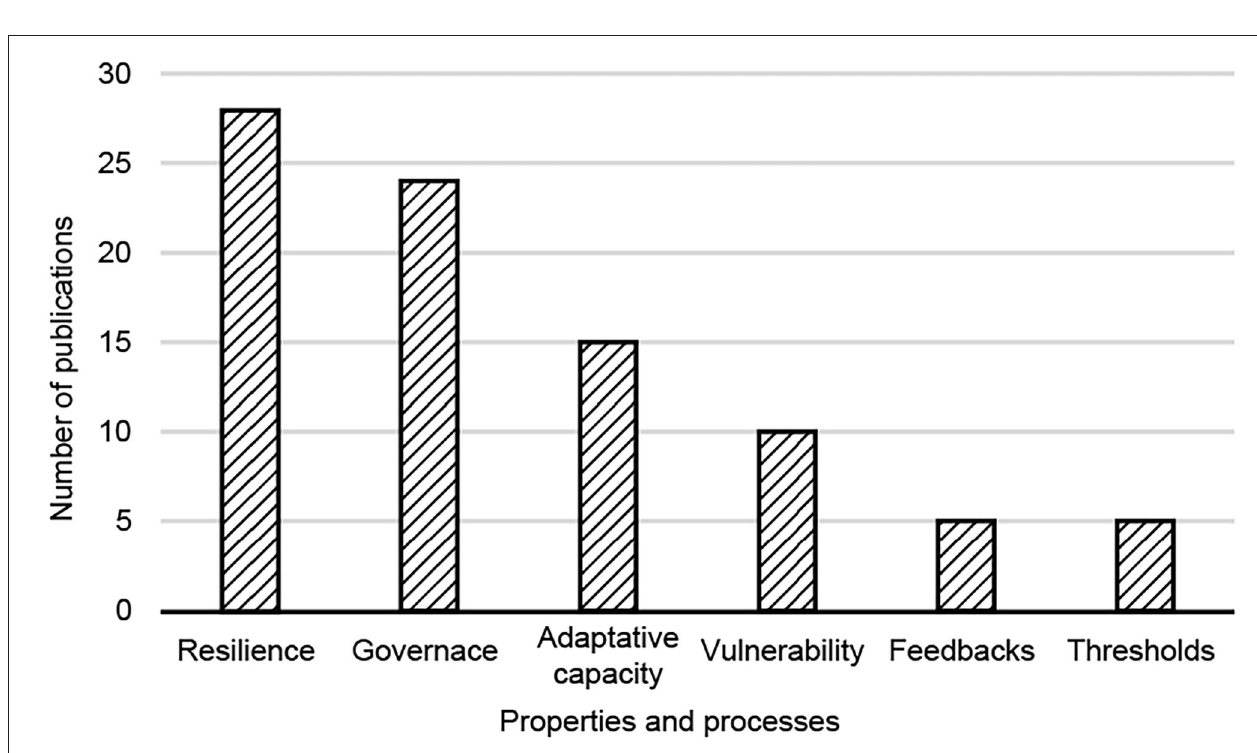
FIGURE 4 | Analysis by properties and processes. The figure shows the number of publications on coastal or marine SESs that dealt with resilience, vulnerability, adaptive capacity, governance, feedbacks, and thresholds in this review.